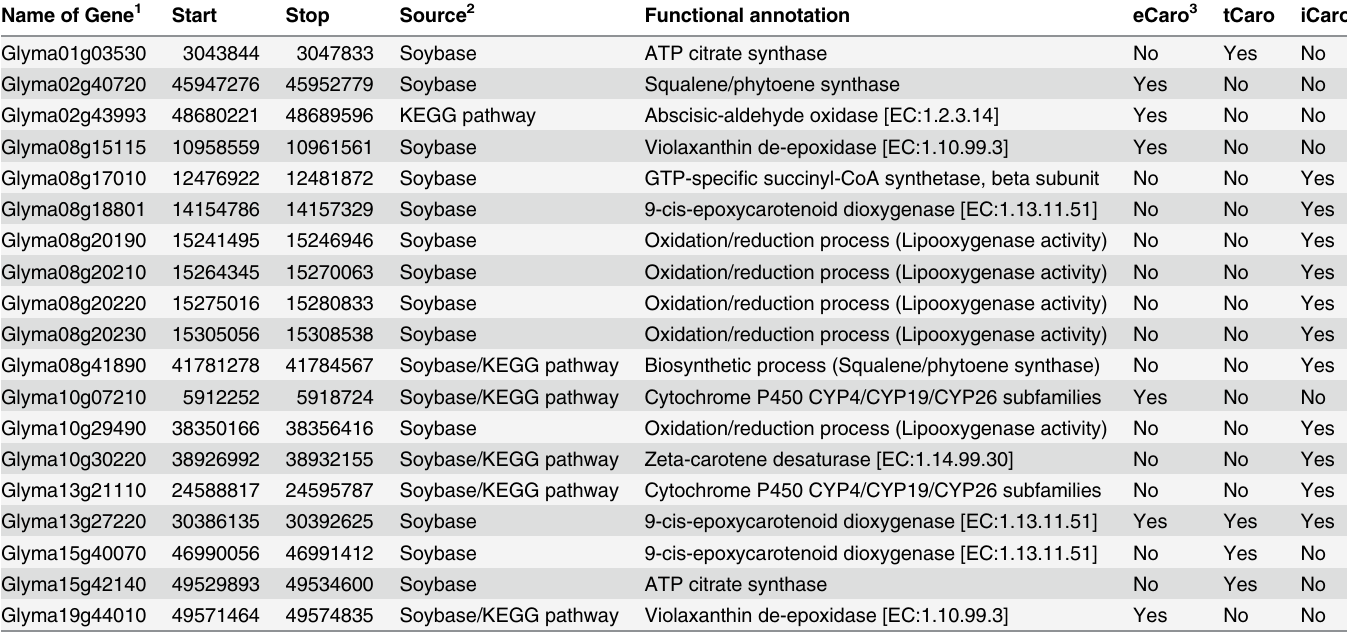
Table 2. List of 19 known carotenoid-related genes within a ± 3MB region of the 28 putative candidate SNPs identified as significantly associated with carotenoid content. Genes were identified in Soybase (www.soybase.org) using the search term “ carotenoid ” . Name of Gene